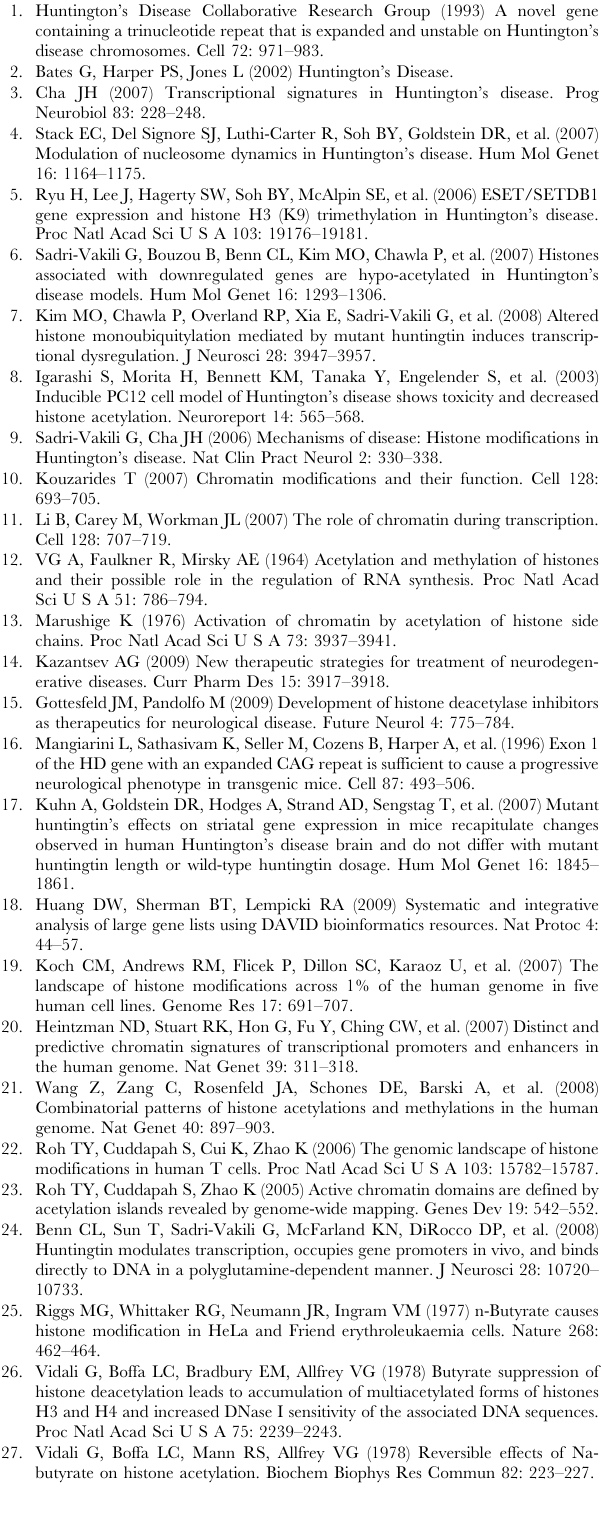
Table S6 Gene Ontology (GO)-Biological Process (GO- TERM_BP_FAT) Functional Annotation Clustering of ‘‘Ectopically acetylated in TG’’